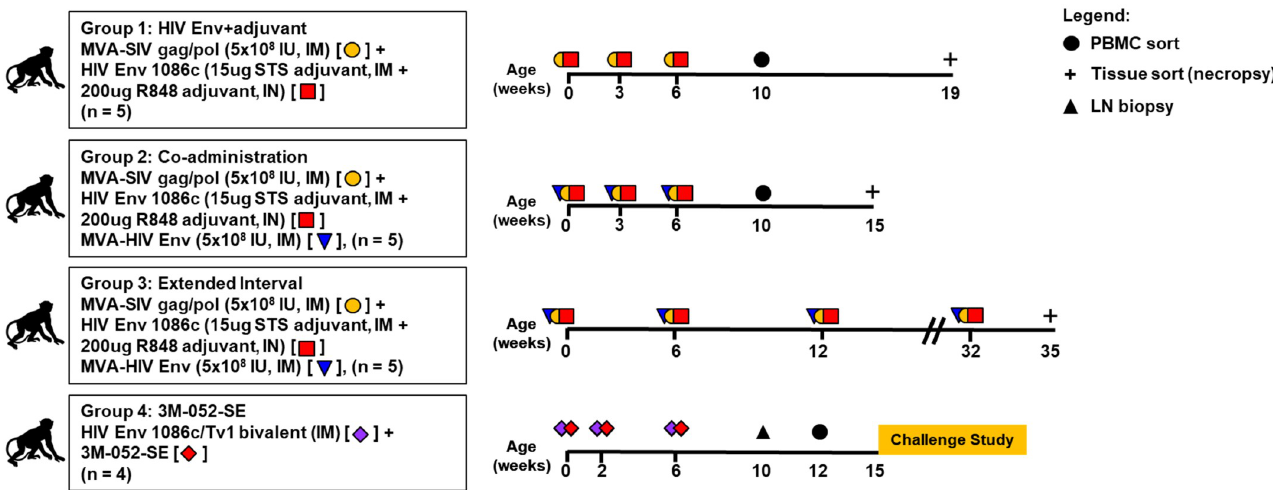
Fig 1. Animal study design and immunization schedule. Infant rhesus macaques from four immunization schedules were included. HIV Env+adjuvant group was immunized with MVA-SIV gag/pol and HIV Envelope (Env) 1086c adjuvanted with 15 μ g STS, intramuscular + 200 μ g R848, intranasal. Co-administration group was immunized with MVA-SIV gag/pol, HIV Env 1086c adjuvanted with 15 μ g STS, intramuscular + 200 μ g R848, intranasal), and with MVA-HIV Env. Extended interval group was immunized with similar immunogens as Co-administration group with longer immunization intervals. 3M-052-SE group was immunized with HIV Env 1086c/TV1 bivalent adjuvanted with 15 μ g/15 μ g+3M-052-SE, intramuscular. Plus symbol (+) denoted necropsy, IM denoted intramuscular, IN denoted intranasal, and IU denoted infectious unit.